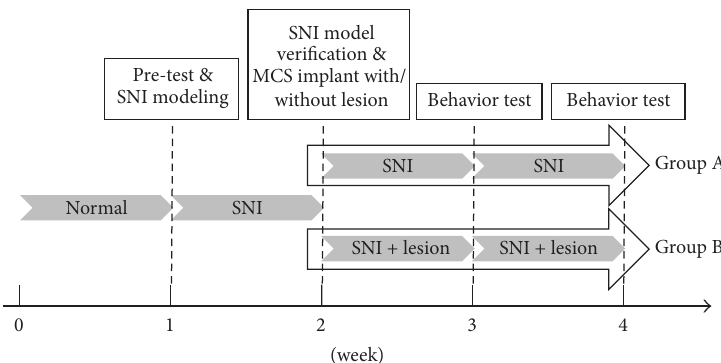
Figure 1: The timetable of spared nerve injury (SNI) modeling and behavioral test in two groups (Group A: neuropathic pain + motor cortex stimulation and Group B: neuropathic pain + rostral agranular insular cortex lesion + motor cortex stimulation).